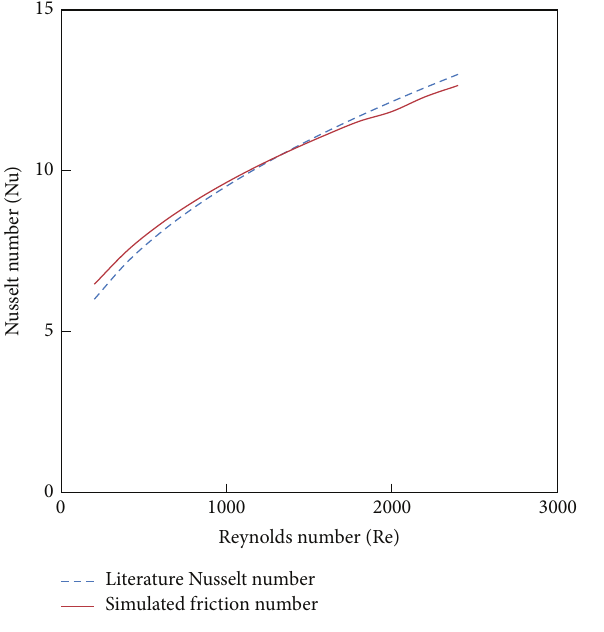
Figure 4: Plain tube simulated friction factor versus literature value.